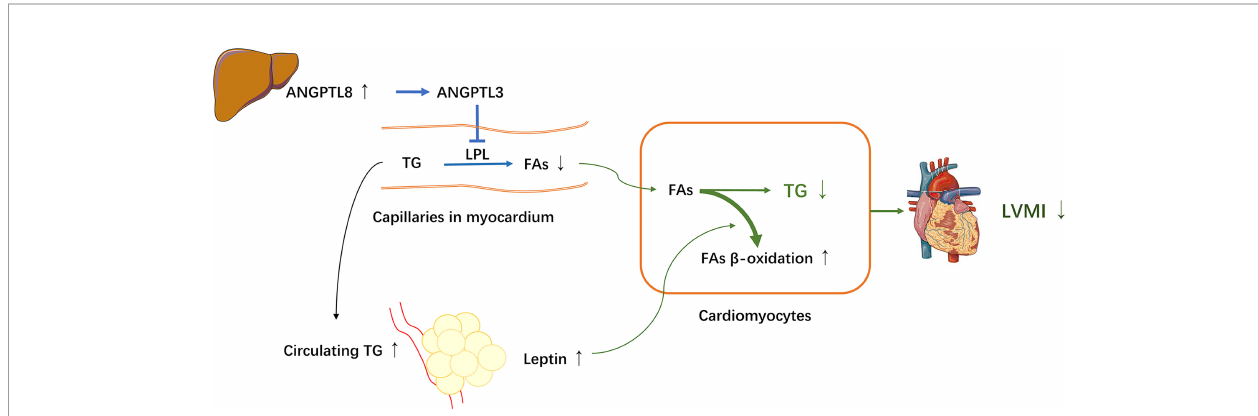
FIGURE 4 | A proposed mechanistic model for interaction between ANGPTL8 and leptin on LVH through triglyceride. The hepatokine ANGPTL8 might facilitate angiopoietin-like protein 3 (ANGPTL3) to inhibit lipoprotein lipase (LPL) activity for conversion of triglyceride (TG) into fatty acids (FAs) in myocardium, resulting in increased circulating TG and decreased FAs uptake into cardiomyocytes, and coordinating the traf fi cking of TG to white adipose tissue for storage, and ultimately, inducing higher leptin secretion. Meanwhile, high leptin levels might stimulate b -oxidation of FAs and inhibit de novo lipogenesis in cardiomyocytes to further prevent myocardial TG accumulation and lipid cardiomyopathy, leading to a favorable LVMI. Thereby, the adipokine leptin and the hepatokine ANGPTL8 cooperate together to decrease cardiac TG involved in mechanism of protective effect on cardiac